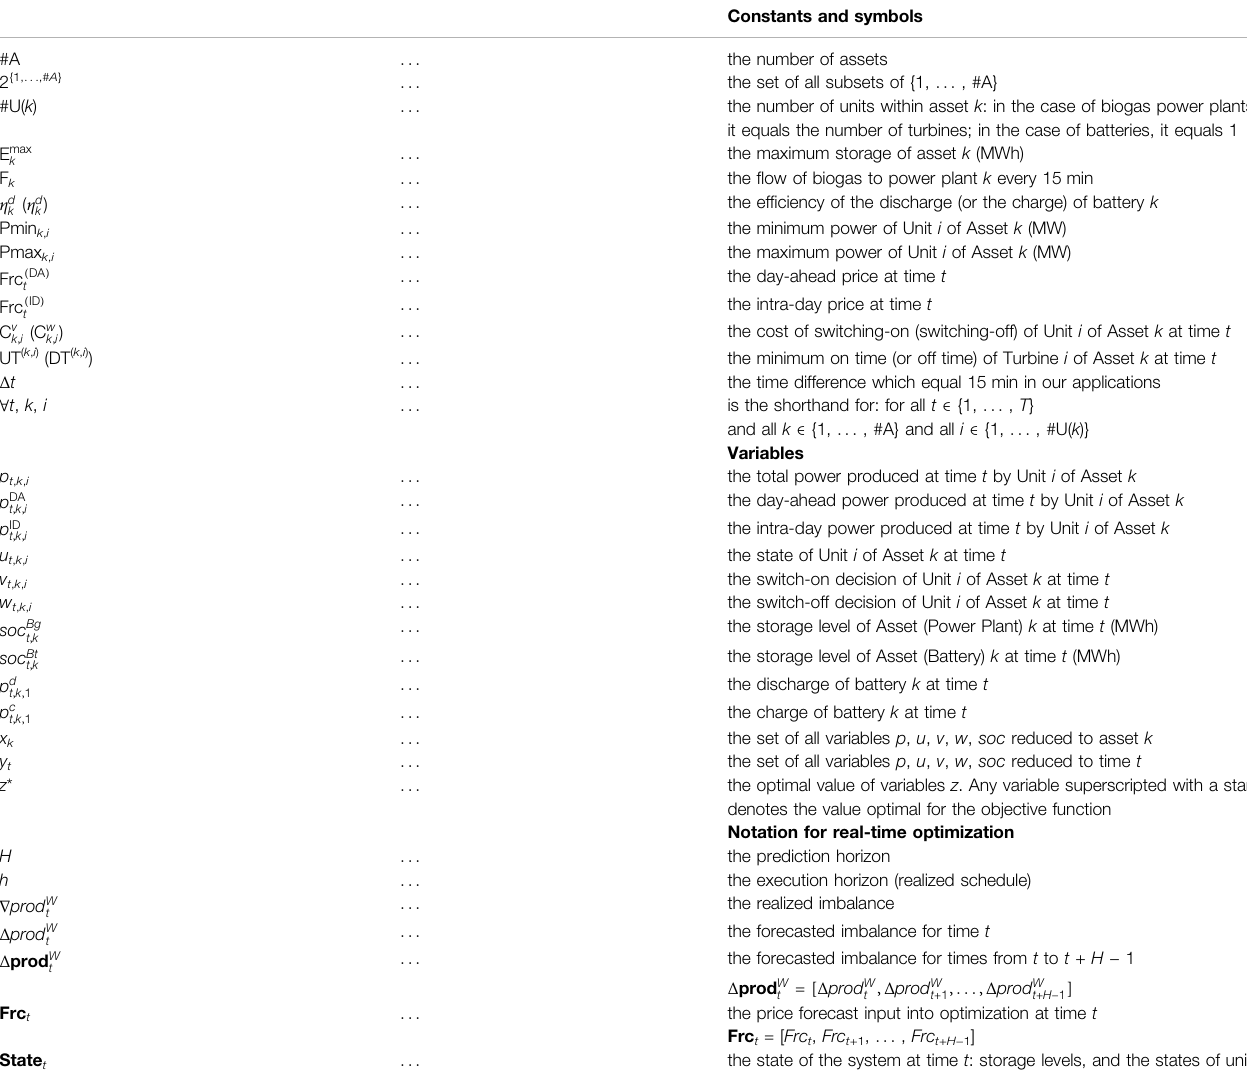
TABLE 1 | Nomenclature.